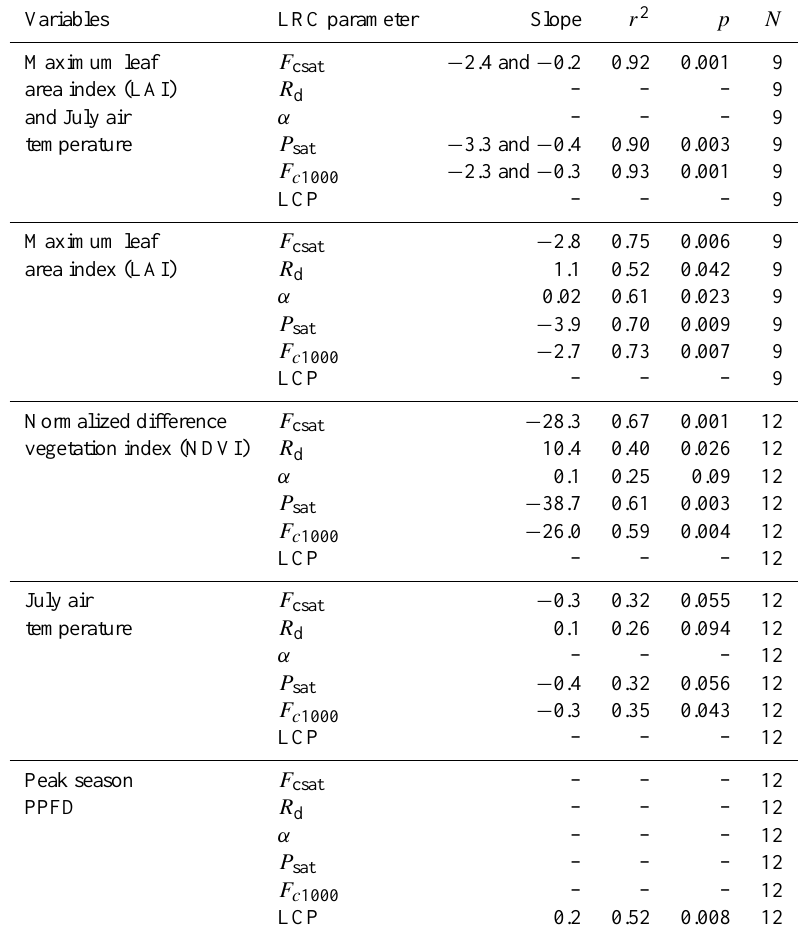
Table 2. Linear regressions between variables (environmental and vegetation properties) and LRC parameters: goodness of fit ( r 2 ), slope and level of significance ( p < 0 .